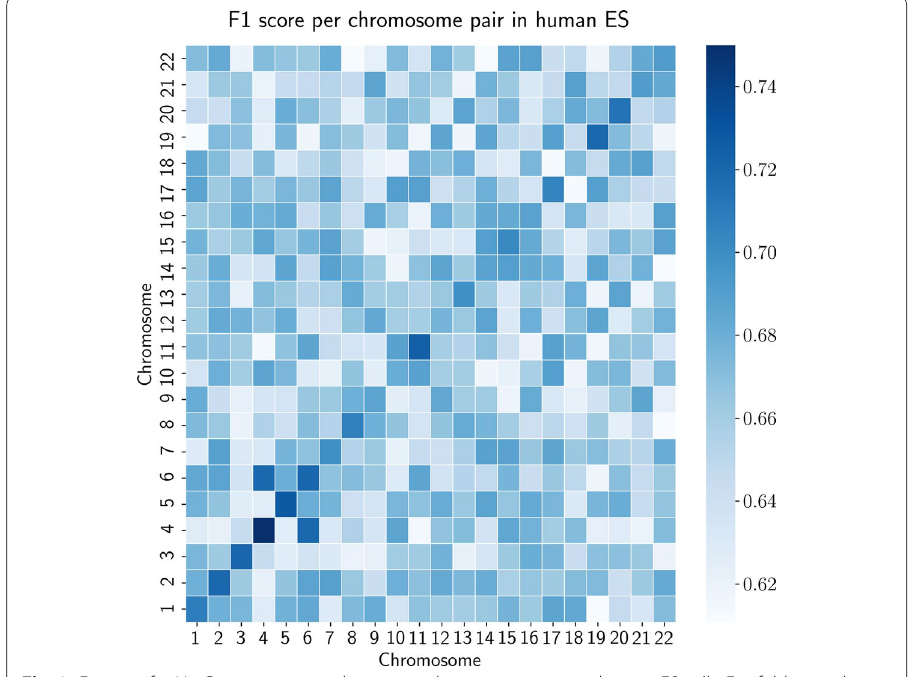
Fig. 3 F1 score for Hi–C interaction prediction per chromosome pair on human ES cells. Fivefold nested cross-validation is independently applied to each chromosome